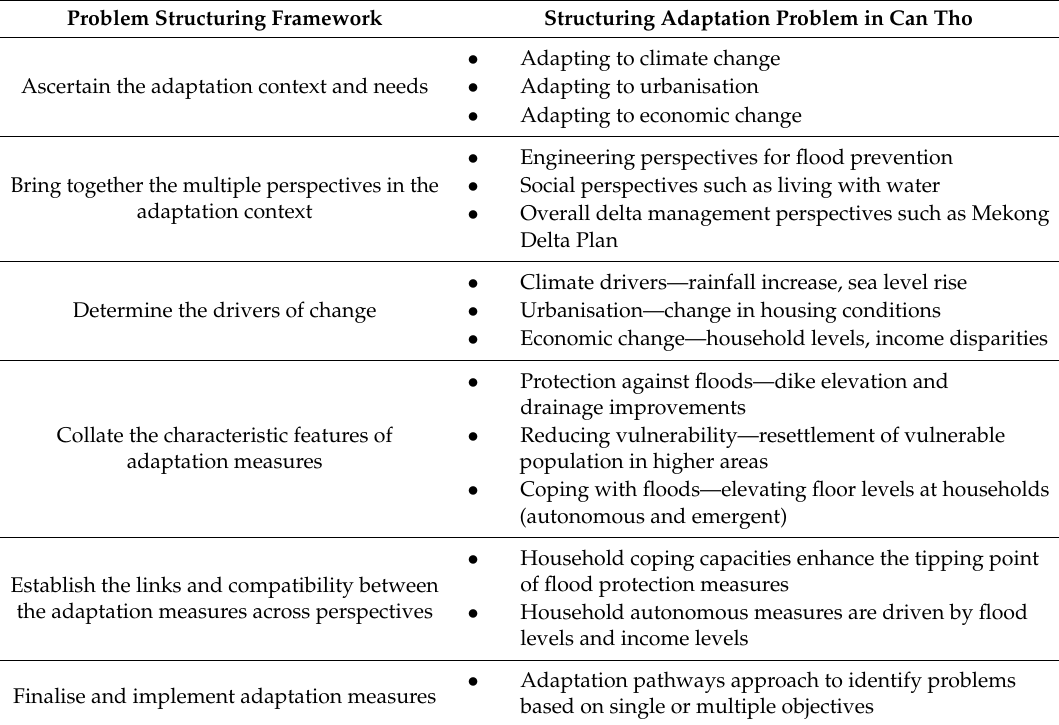
Table 1. Multiple (dual) perspective adaptation problem structuring in Can